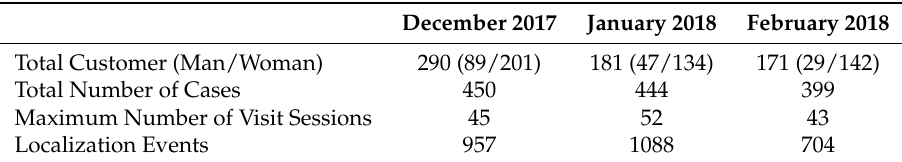
Table 5. Basic statistics of the preprocessed data.